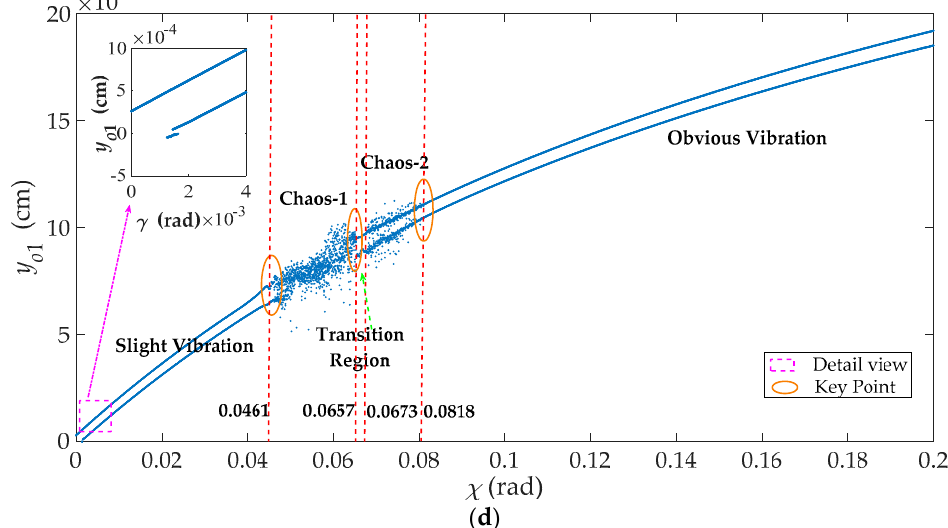
Figure 6. Bifurcation diagrams of the hydraulic unbalance forces ( P x and P y ) and the axis coordinates ( x o 1 and y o 1 ) with the deviation of the blade exit flow angle ( χ ) increasing from 0 rad to 0.2 rad. ( a ) Hydraulic unbalance force P x ; ( b ) Hydraulic unbalance force P y ; ( c ) Axis coordinate x o 1 ; ( d ) Axis coordinate y o 1 .